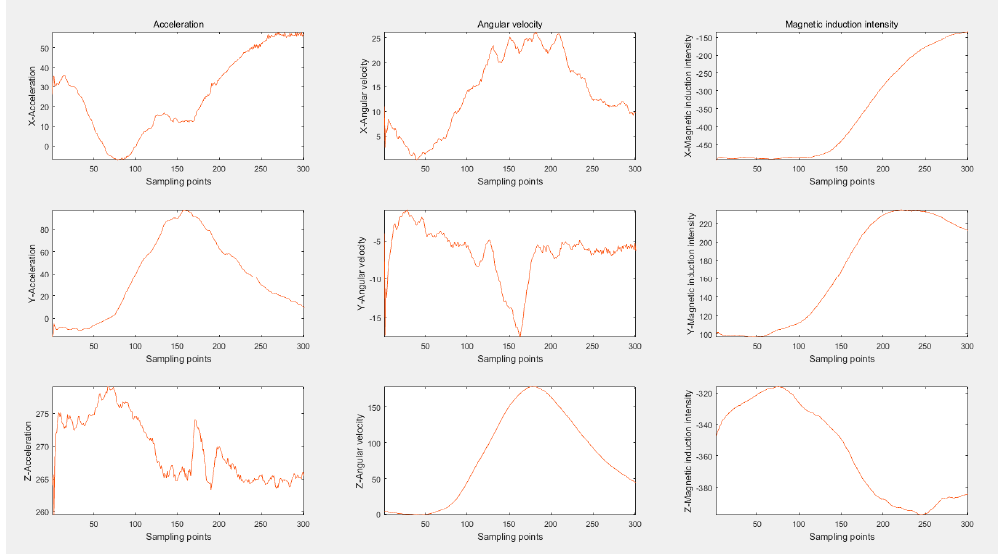
Figure 7. The actual nine-axis data portraying LT.